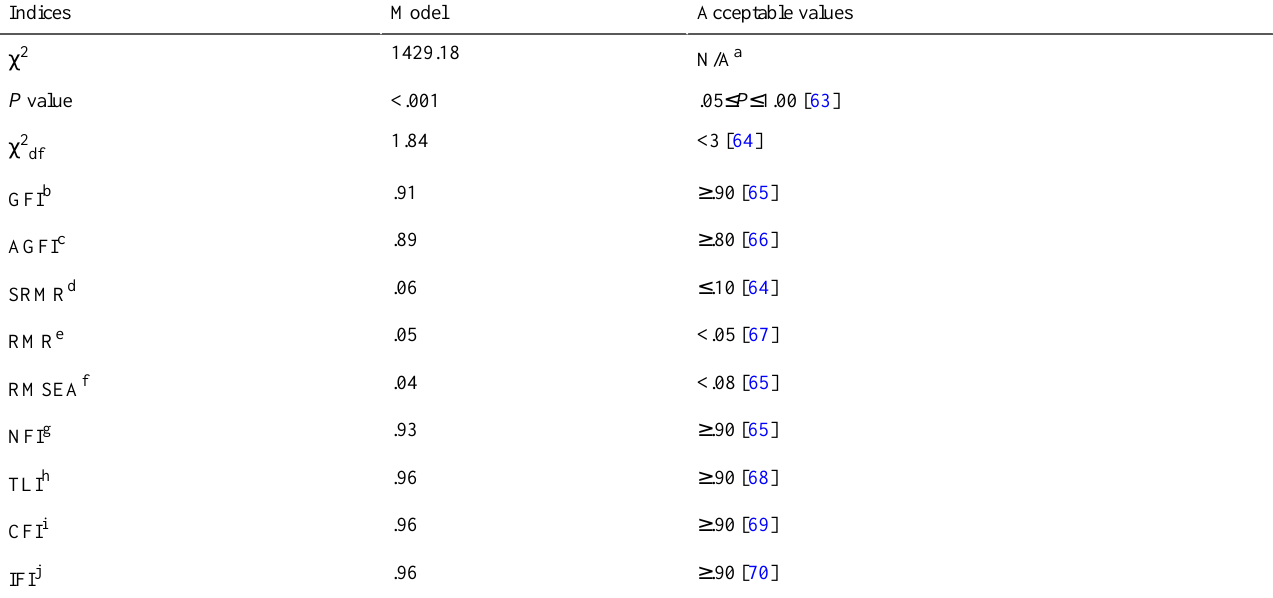
Table 3. Model fit indices of the structural